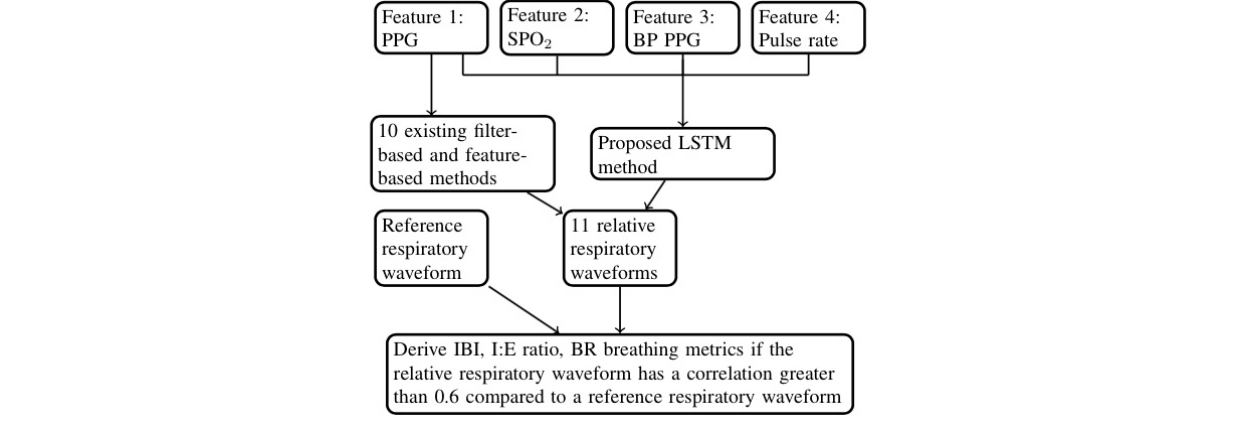
Figure 1. Using existing filter-based and feature-based methods, 10 relative respiratory waveforms were derived from a photoplethysmogram (PPG) signal, and another relative respiratory waveform was derived using a long short-term memory (LSTM) that accepts PPG, arterial blood oxygen saturation (SPO2), band-passed (BP) PPG, and pulse rate inputs. BR: breathing rate; I:E: inspiration-expiration ratio; IBI: interbreath interval.